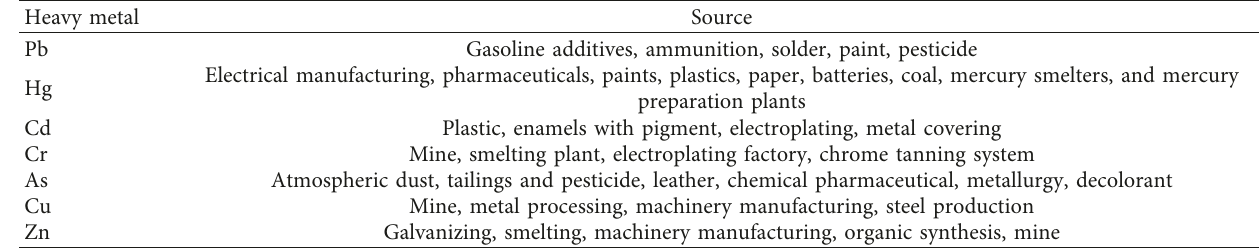
Table 1: Source of heavy metals in MSWI fly ash.